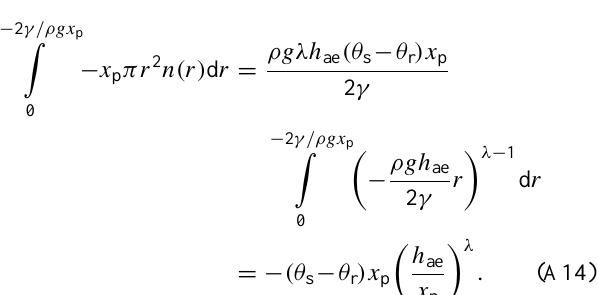
Fig. A1. Hypothetical distributions of liquid, gas, and liquid-gas interfaces for a simple system of vertical capillaries connected by horizontal throats. The lower end of the vertical capillaries is in contact with open water at a constant level (not